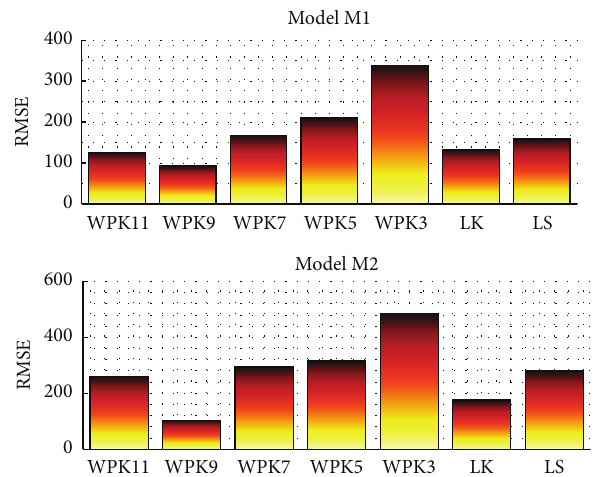
Figure 26: Comparison of the averaged values of the RMSE coefficient obtained by the regression of models M1 and M2 for all the tested dielectrics and insulation